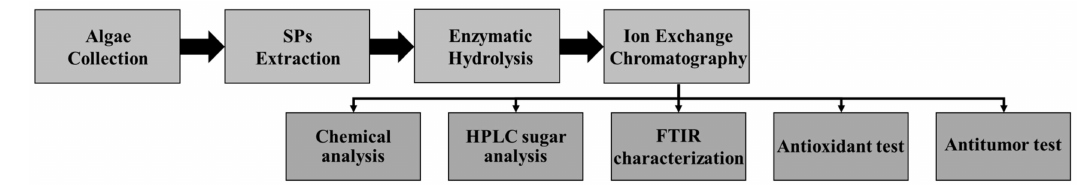
Figure 1. Illustration of the framework of this study.